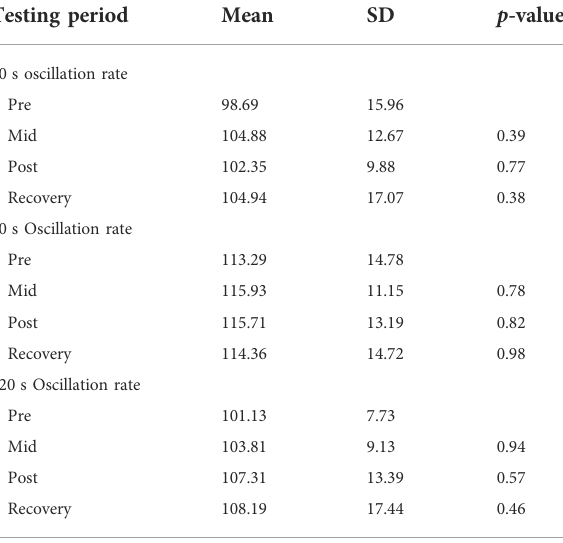
TABLE 6 Thein fl uenceof30 s,60 s,and 120 soscillationsof80/20and 30/70O2/N2concentrationsonalveolar-arterialoxygendifference.